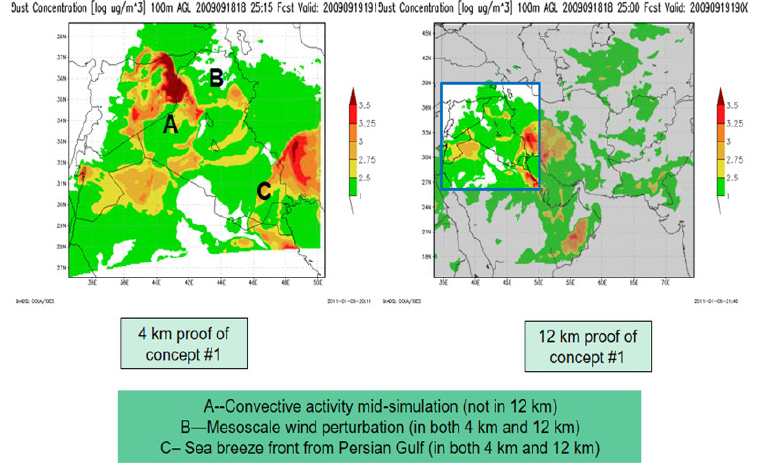
Figure 10. Comparison of 100 meter above ground level dust concentration (ug/m ^3 ) between a 4-km WRF run with convective parameterization turned off ( left ) and a 12 WRF run with convective parameterization turned on ( right ). Both models initialized with analyses valid 1800 UTC on 18 Sept 2008, and forecasts valid 1900 UTC 19 Sept 2008.